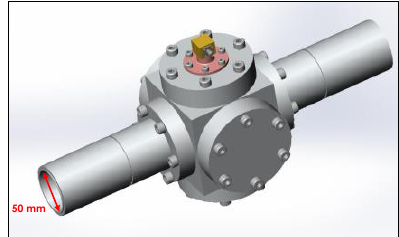
Fig. 8. Inline power monitor with multiple ports for polarization